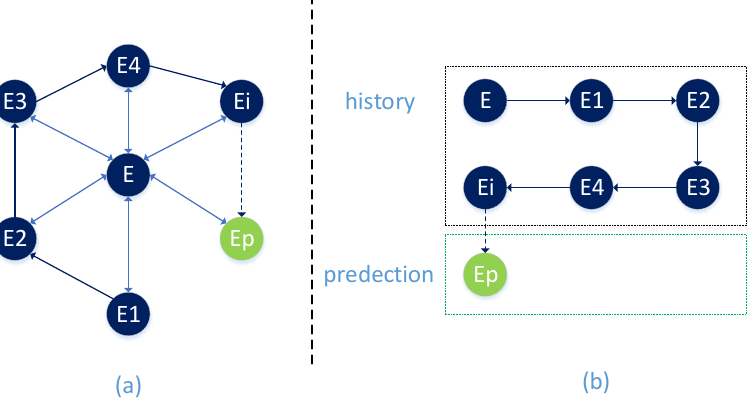
Figure 4. Temporal graph structure for a single node. ( a ) Graphic representation of Spatio-temporal relationship of a road section. ( b ) Representation of traffic flow at different time periods on a road